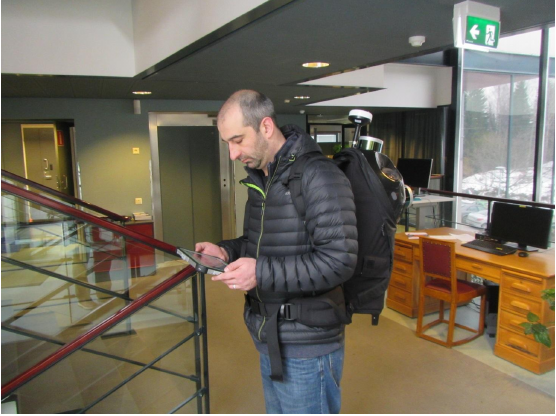
Figure 7. Mapping the hallway test site with Leica Pegasus: Backpack.